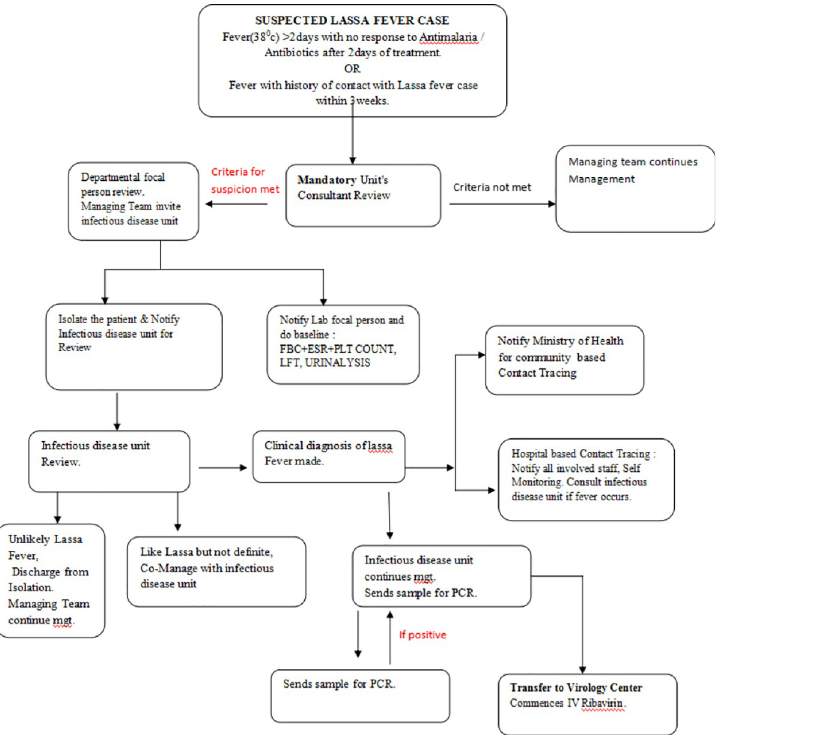
Fig 3. (Flow chart for the management of suspected Lassa fever cases in